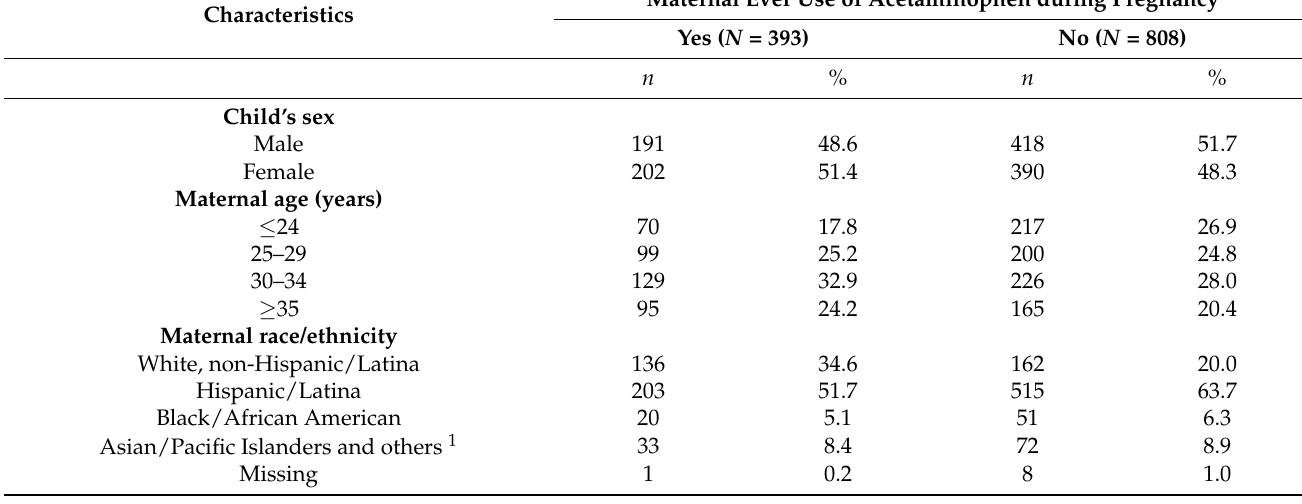
Table 1. Characteristics of the participants by maternal acetaminophen use during pregnancy, a population-based cohort study in Los Angeles (LA), California, 2003–2007. Characteristics